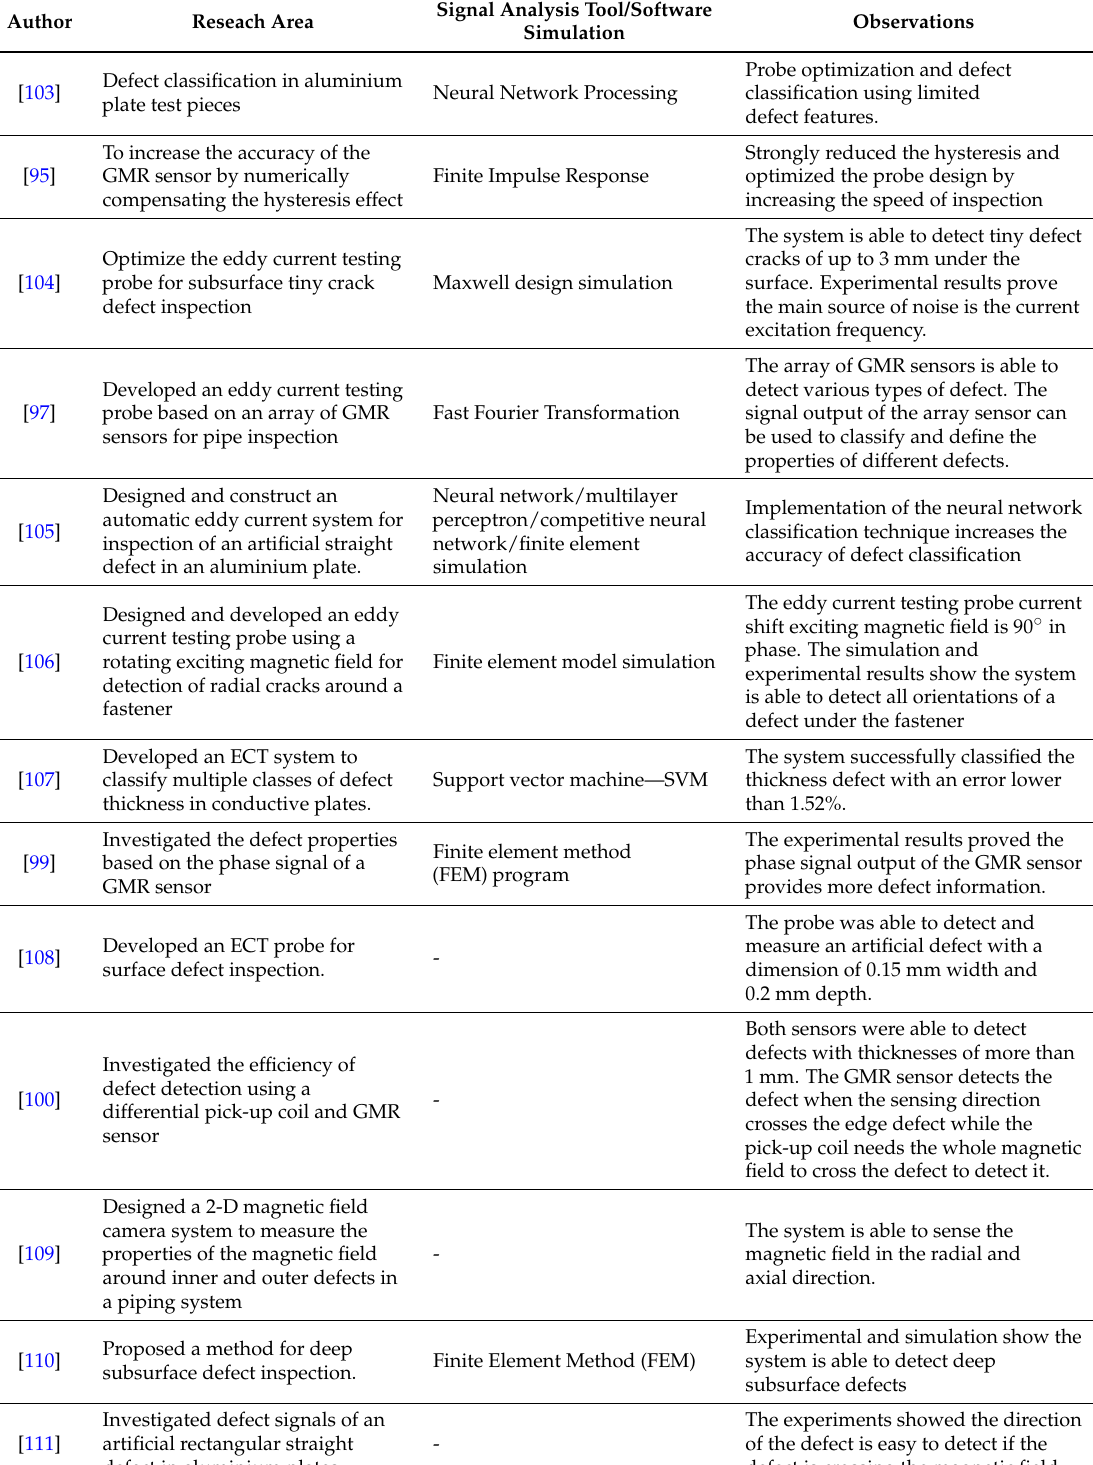
Table 5. Summary of previous studies on application of GMR sensor in eddy current